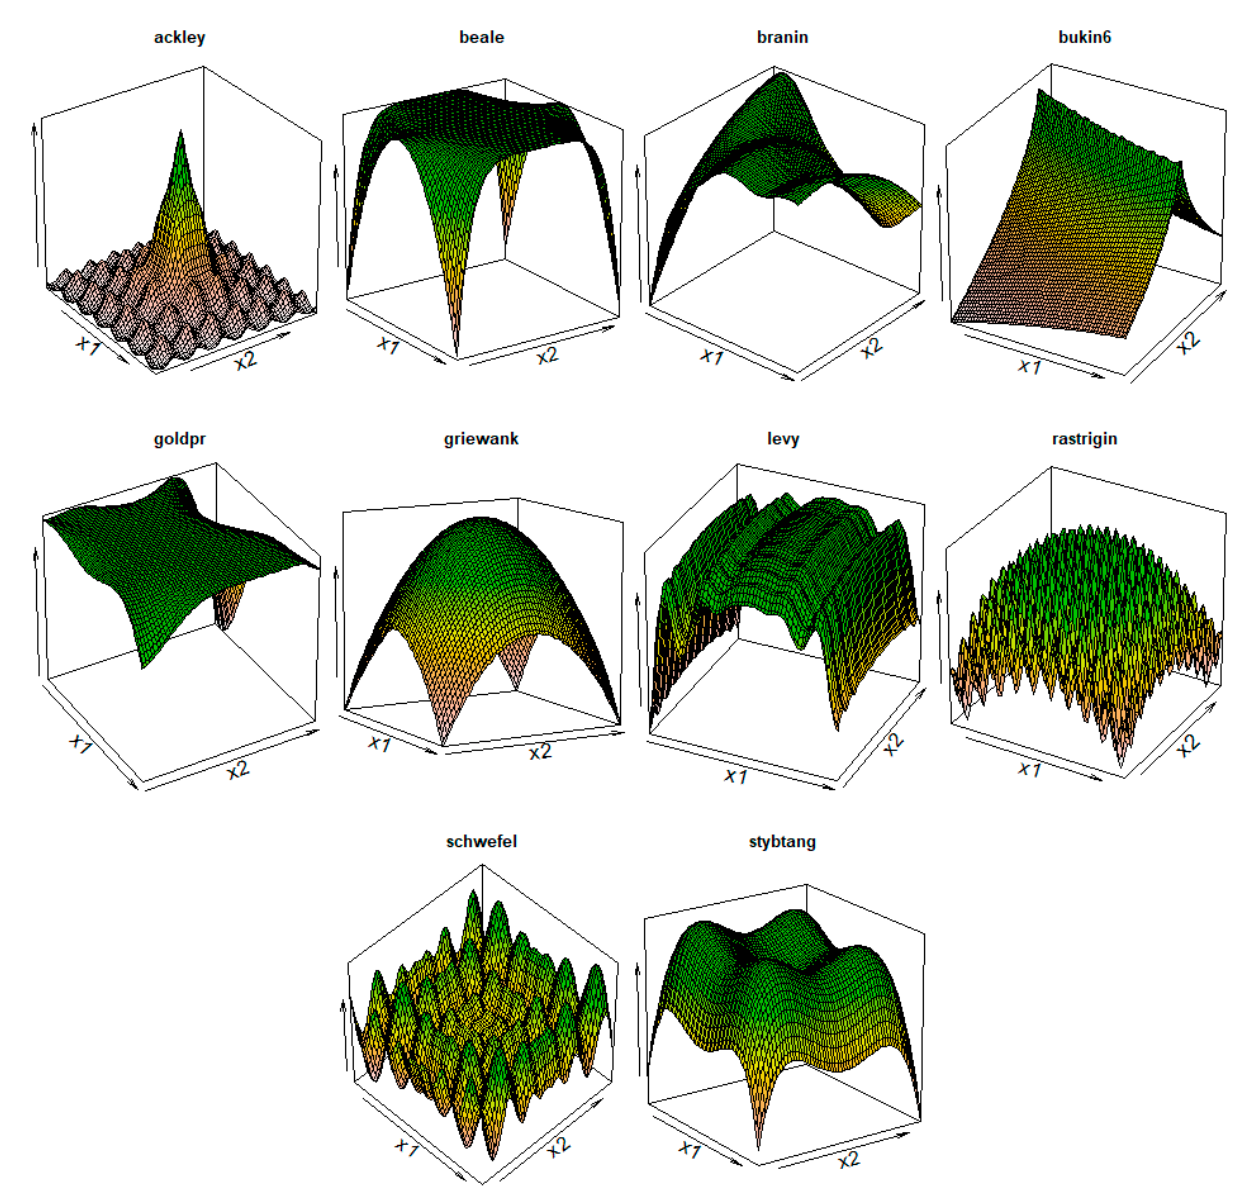
Figure A1. The 10 test problems considered in this study.